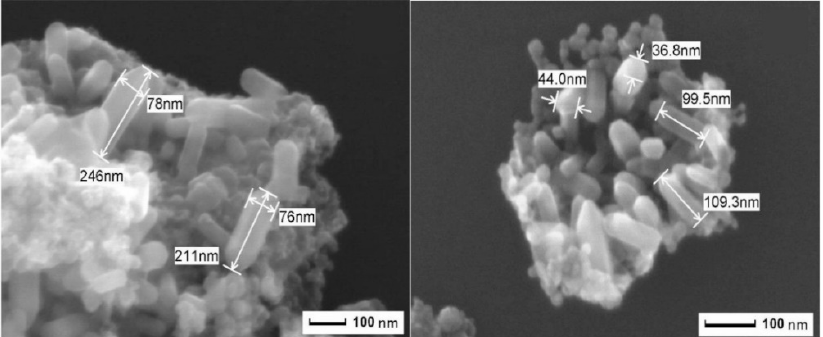
Figure 5. FESEM (field emission scanning electron microscopy) images of ZnO synthesized using garlic bulb extracts. Reprinted from [103] with permission from Elsevier.